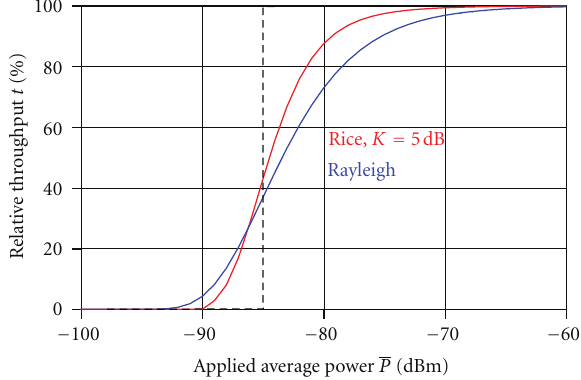
Figure 2: Illustration of the e ff ect of Rayleigh fading (blue curve) and Rician fading ( K = 5dB, red curve) on observed throughput for an MCS threshold power of − 85dBm. See text for